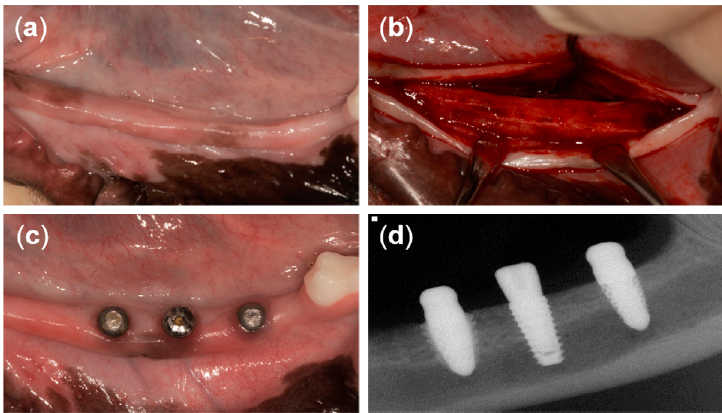
Figure 4. Clinical photographs from the present study. ( a ) Twelve weeks after tooth extraction, ( b ) horizontal incision and flap reflection, ( c ) 8 weeks after implant placement, and ( d ) periapical radiograph of three different types of implants after 8 weeks of healing.